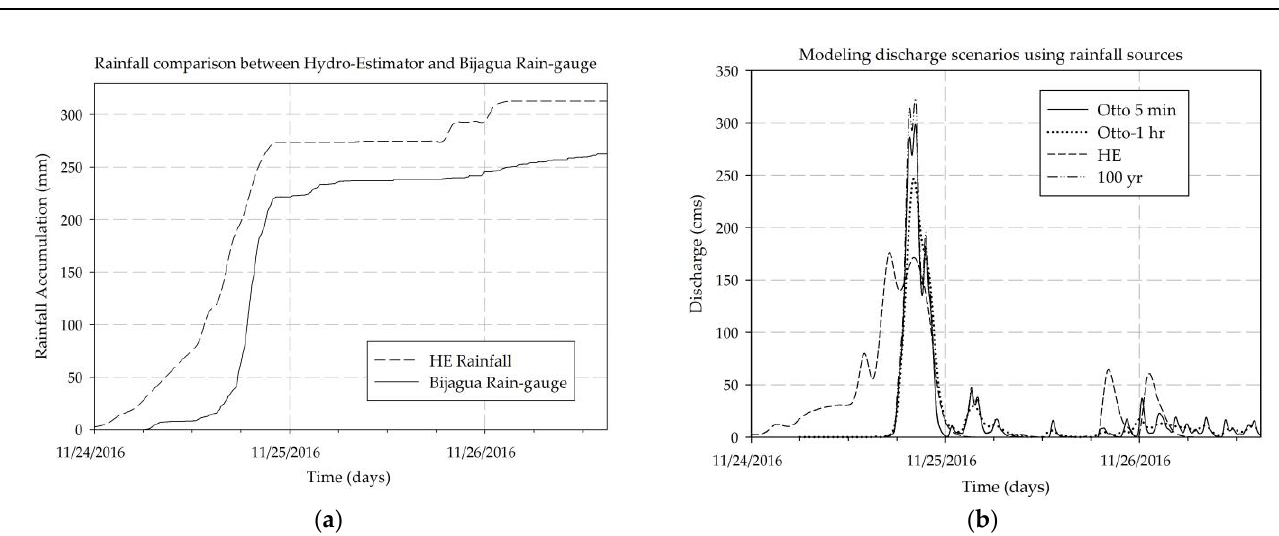
Figure 2. ( a ) Rainfall accumulation comparison between Hydro-Estimator and Bijagua ’ s rain gauge; ( b ) Hurricane Otto hydrographs for Bijagua ’ s rain gauge at 5 min and 1 h, 100-year return period; and Hydro-Estimator rainfall.